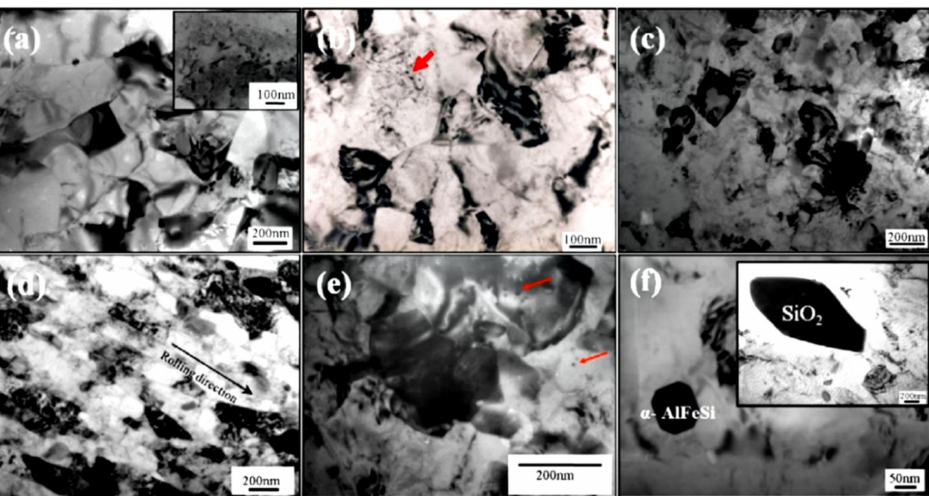
Figure 39. TEM micrographs of HRDSR AA6061 after thickness reduction of 70%: ( a ) furnace-cooled (FC) HRDSR Al, ( b ) water-quenched (WQ) HRDSR Al and ( c ) WQ-HRDSR Al after aging at 100 ◦ C for 48 h. ( d ) WQ-HRDSR Al after aging at 100 ◦ C for 48 h (taken on RD–ND plane) ( e ) β (cid:48)(cid:48) or β (cid:48) precipitates in the aged WQ-HRDSR Al ( f ) SiO 2 (>200 nm) and α -AlFeSi particles ( ∼ 50 nm) commonly detected in all the HRDSR 6061 Al, reproduced from [19], with permission from Elsevier, 2009.